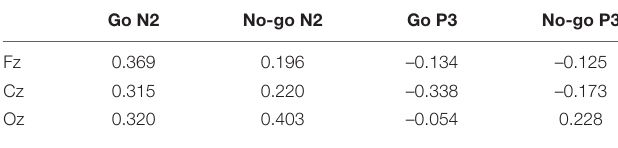
TABLE 2 | Correlation between RT and ERP